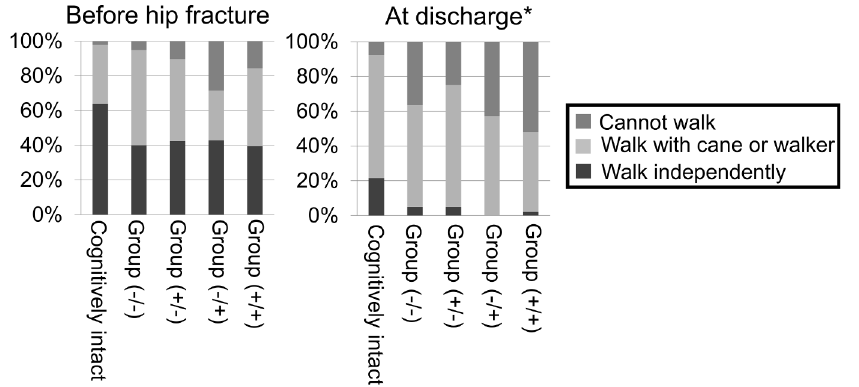
Fig 3. Transition of walking ability. (cid:3) p < 0.001 Chi-squared test among subgroups.